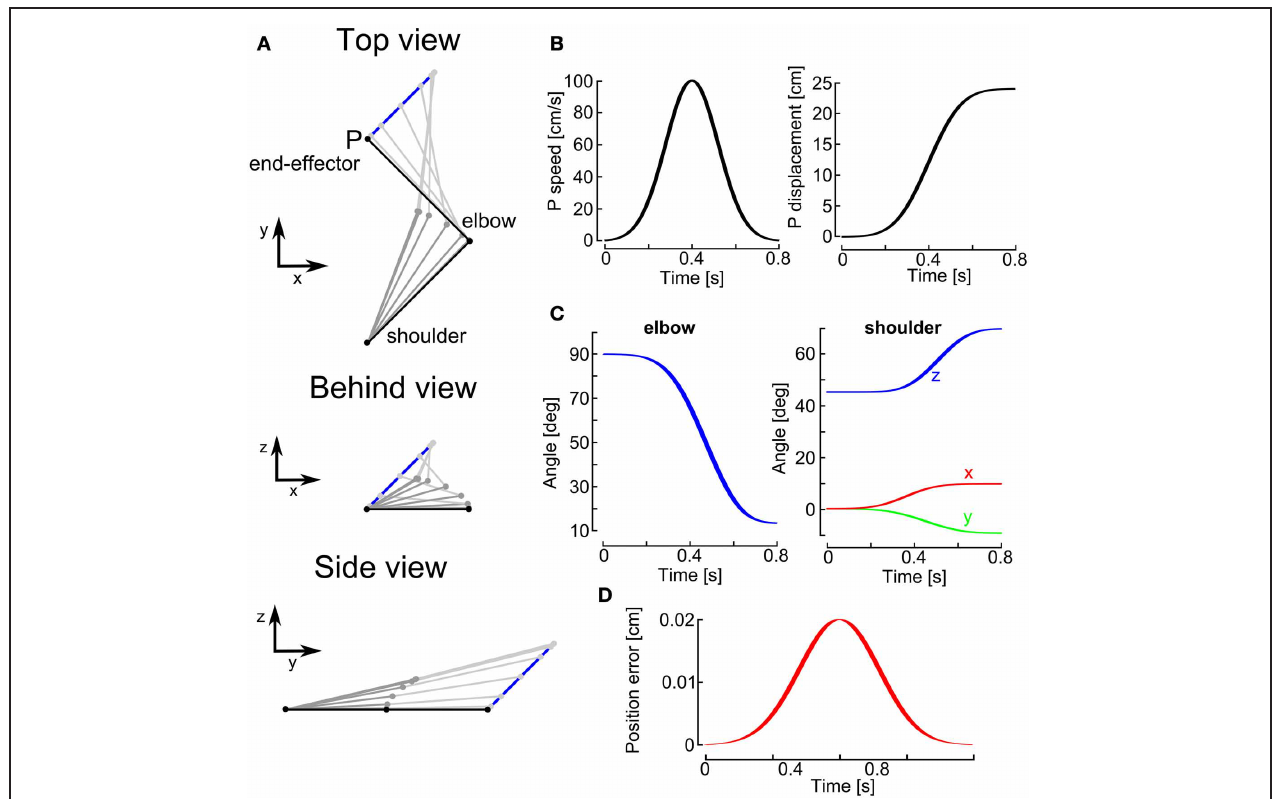
function of time: the movement is a typical bell-shaped speed profile lasting 800ms and with a peak velocity of 100cm/s. The end-effector displacement is about 25cm. (C) The estimated elbow (left) and shoulder (right) rotation angles are represented as a function of time. For the shoulder, there are three components of rotation: around the x-axis (red line), the y-axis (green line), and the z-axis (blue line). (D) Representation of the position error, the norm of the difference between the estimated and actual end-effector position, as a function of time. The maximal error is about